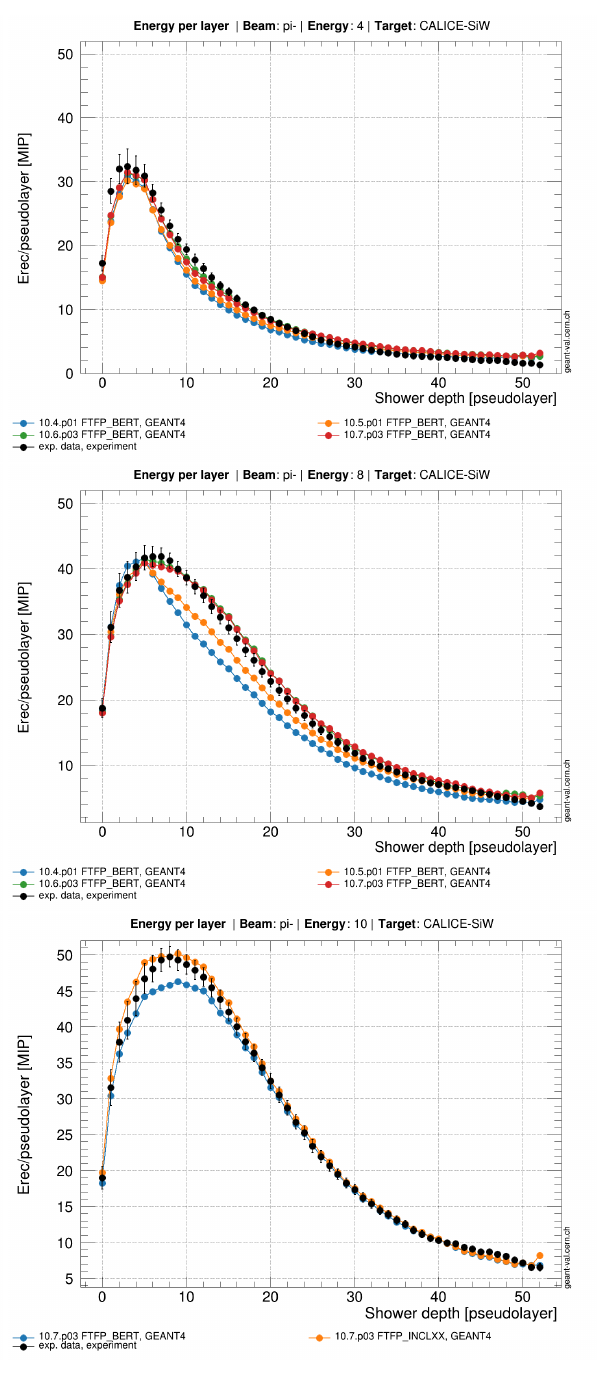
Figure 7. Longitudinal energy profiles for 2 ( top-left ), 4 ( top-right ), 6 ( center-left ), 8 ( center-right ), and 10 ( bottom-left ) GeV π − events. Results from experimental measurements and Geant4 sim- ulation with the FTFP_BERT PL and releases from 2017 to 2020. Bottom-right : Comparison of the same variable as simulated with the FTFP_BERT and the FTFP_INCLXX PLs from the Geant4 10.7.p03